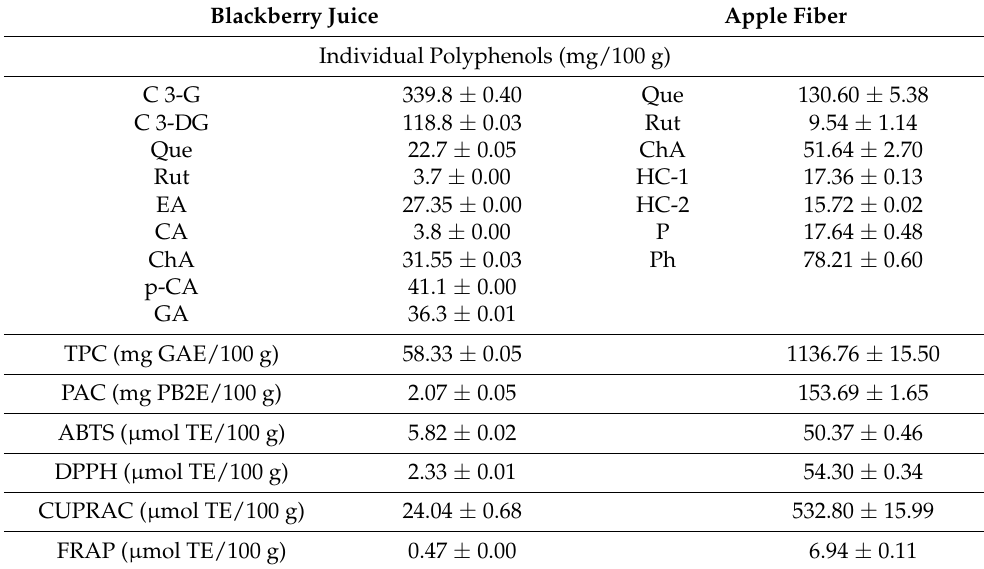
Table 2. Characterization of blackberry juice and apple fiber.